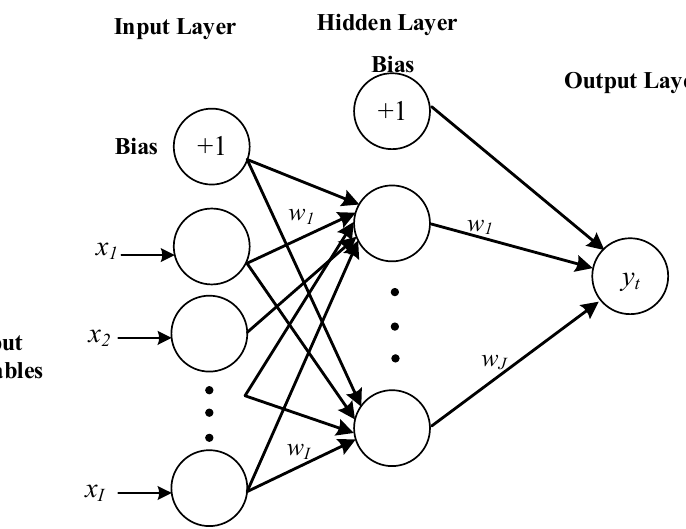
Figure 3. Schematic of an artificial neural network model.